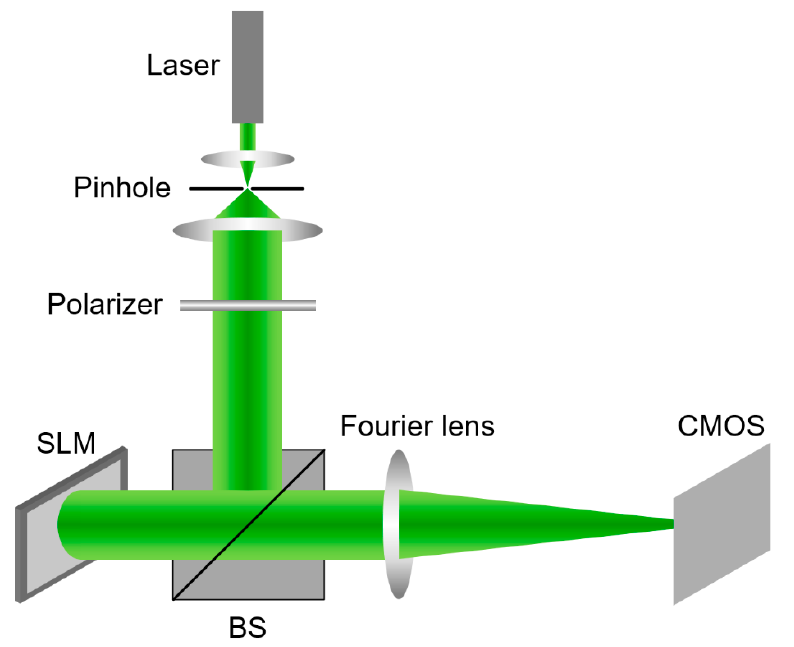
Figure 8. The schematic of the optical setup.